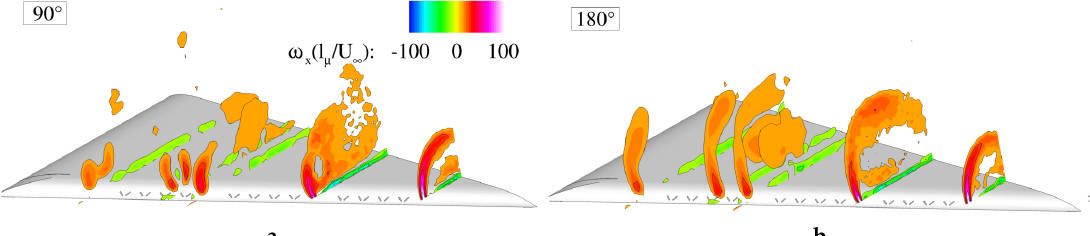
Figure 17. Phase averaged vorticity distribution at α = 45 ◦ ( a ) PIV axial vorticity, blowing on, when the jets are switched off, and ( b ) PIV axial vorticity, blowing off, T /4 after